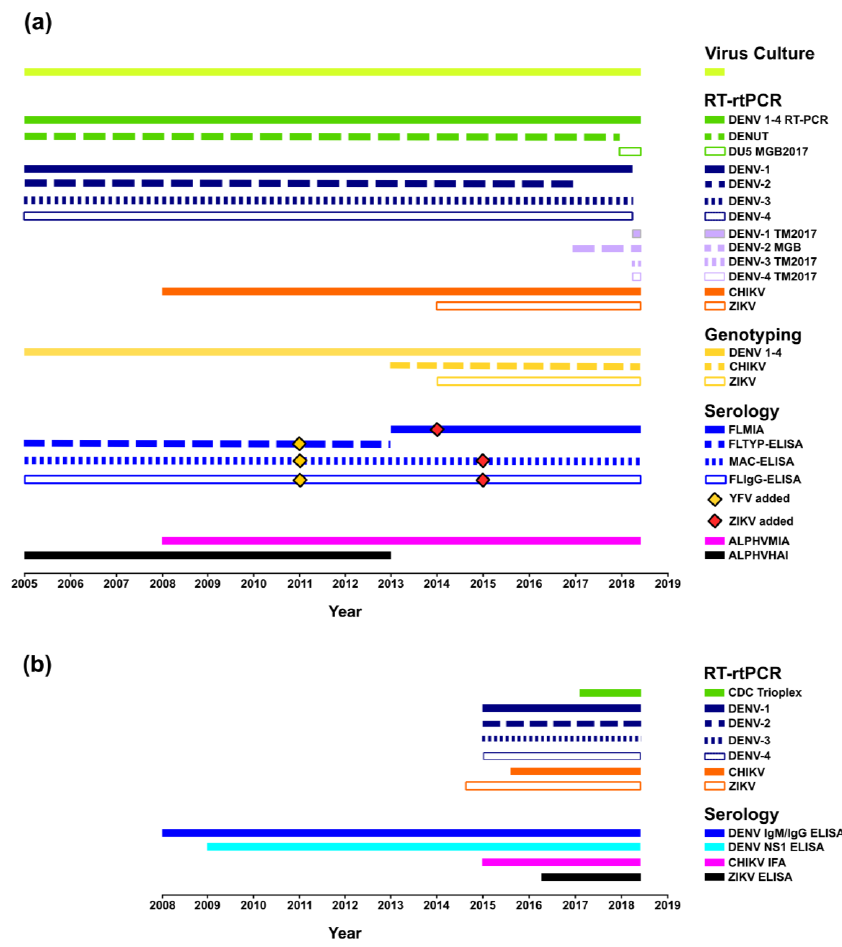
Figure 1. Reference DENV testing performed by PHV and the Institute of Environmental Science and Research Limited (ESR) (https://doi.org/10.6084/m9.figshare.6164183.v1). ( a ) Timeline